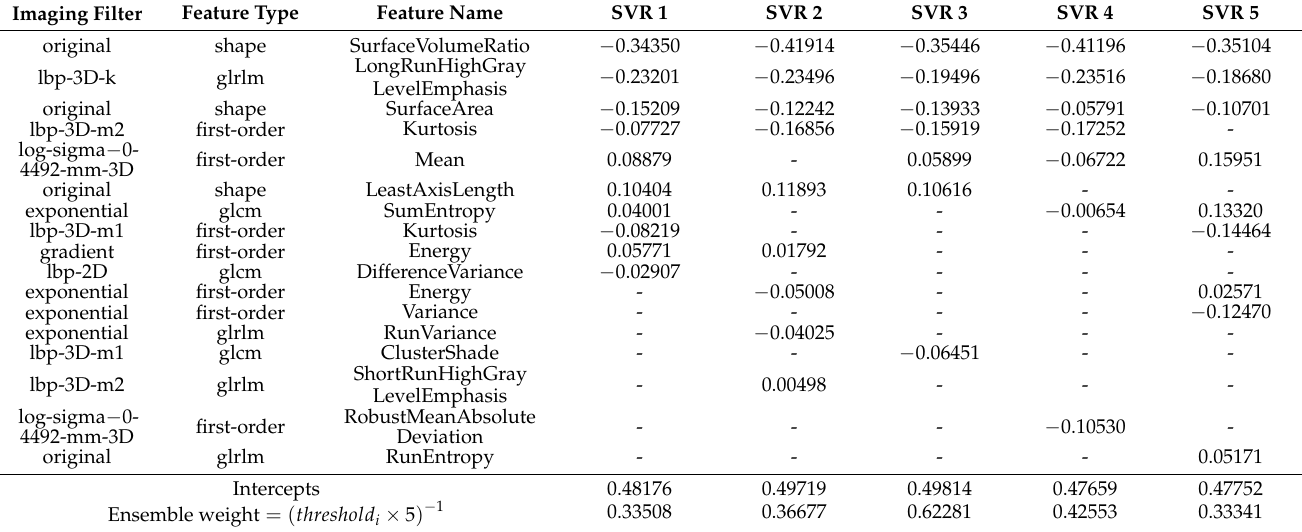
Table 4. Coefficients of the linear support vector regression in the ensemble model proposed to discriminate early nasopharyngeal carcinoma (NPC) from benign hyperplasia on MRI. Features were ordered based on their nomination frequency across the five models, as well as their values in the first fold’s support vector regression (SVR1). These features were selected from a pool of 422 features using the proposed boosted-bagged repeated elastic net technique (BB-RENT). The ensemble weights were determined using the reciprocal of the Youden index threshold divided by the number of models in the ensemble, after which the threshold for nasopharyngeal carcinoma was normalized to ≥